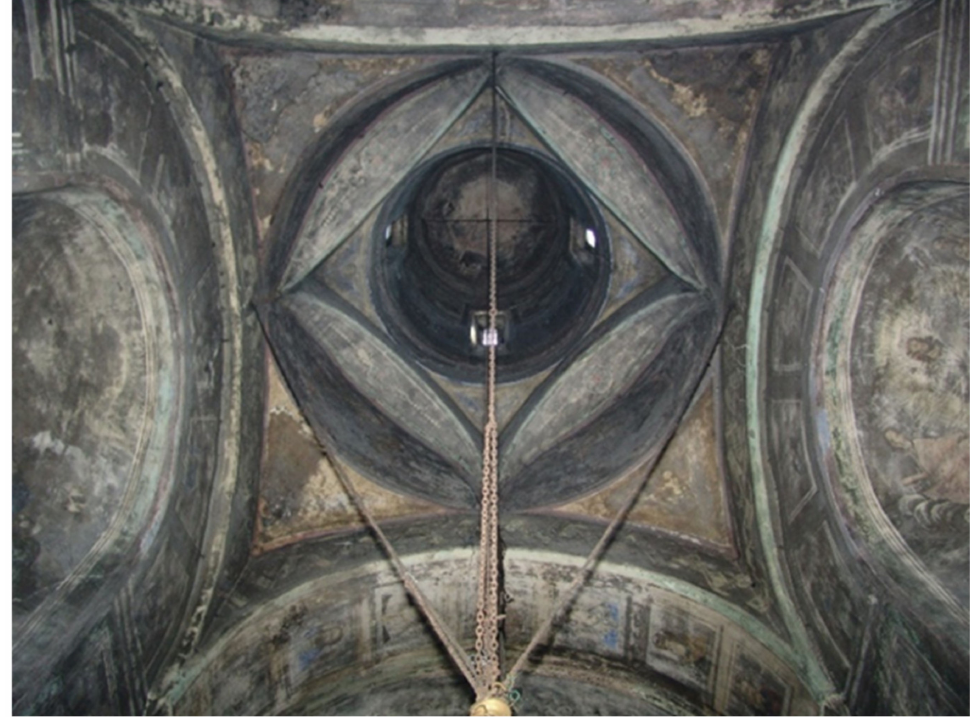
Figure 2. The interior of the tower, perspective at the square-shaped and star-shaped